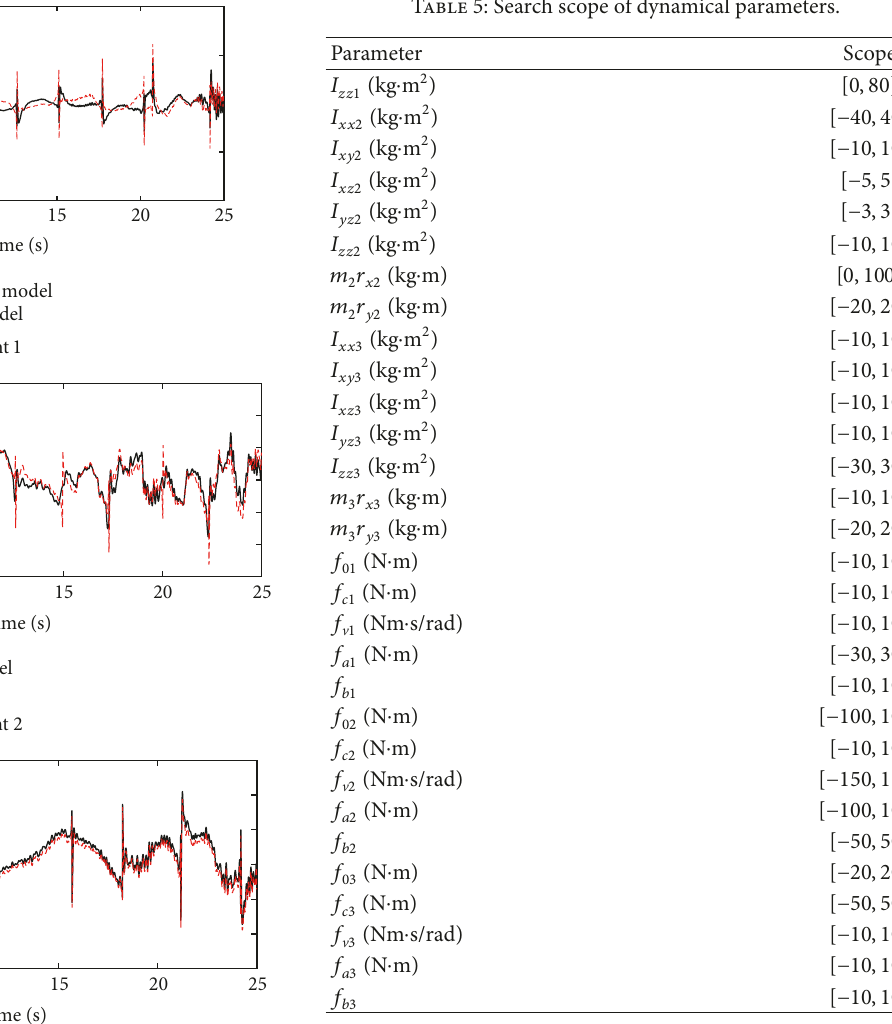
Table 5: Search scope of dynamical